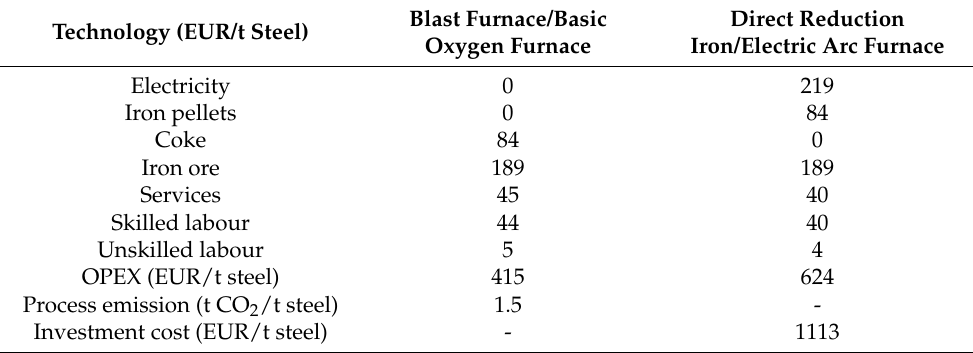
Table 3. Cost analysis of different iron and steel production routes (net of